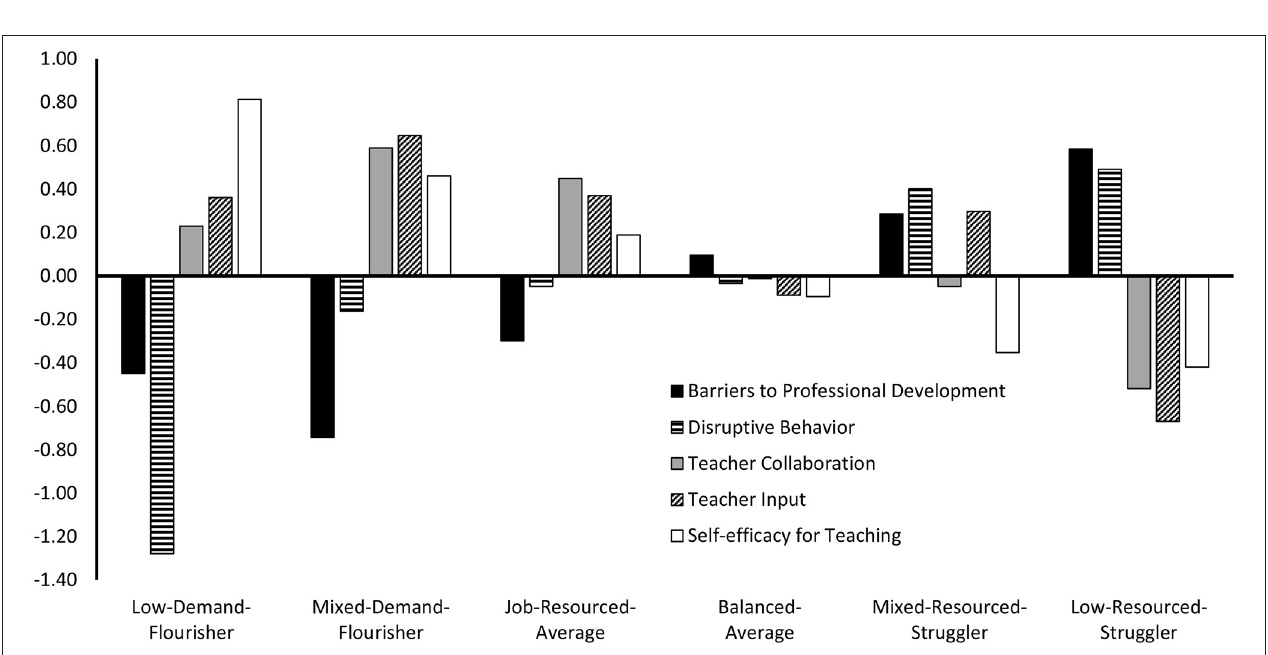
FIGURE 2 | Single-level LPA results of distributional similarity showing teacher profiles for both countries.